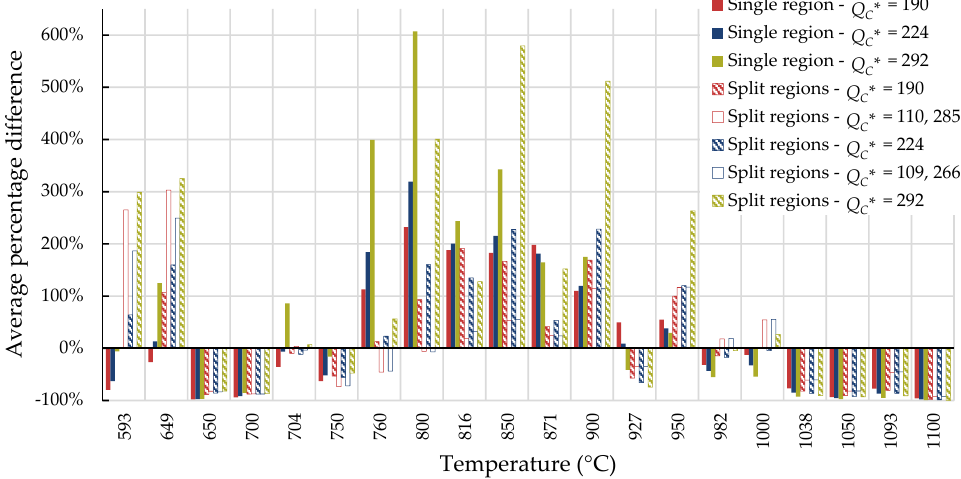
Figure 7. Average percentage difference at each temperature for Inconel 617 using all data to calculate Q ∗ (kJ/mol). C